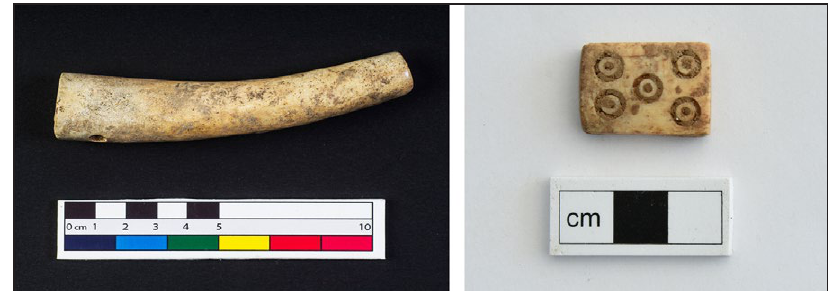
Figure 11: Carved antler tine and polished bone fragment with incised circles, both from Iron Age pits at the site. [Left hand image Conservation Department, Institute of Archaeol- ogy, UCL]. Photo: MBR.